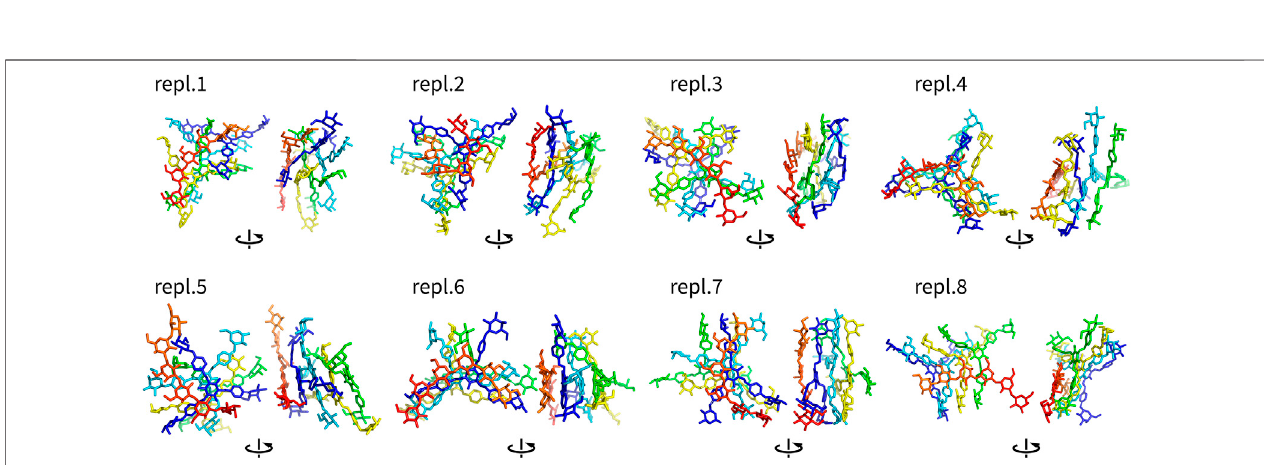
FIGURE6| AssembliesY4H(non-hydrogenatoms)after100 nsshownintwodifferentorientationsrotatedby90 ° .TheyarecoloredbyatomIDinthesystem(Yariv molecules are blue to orange, saccharides are in red).